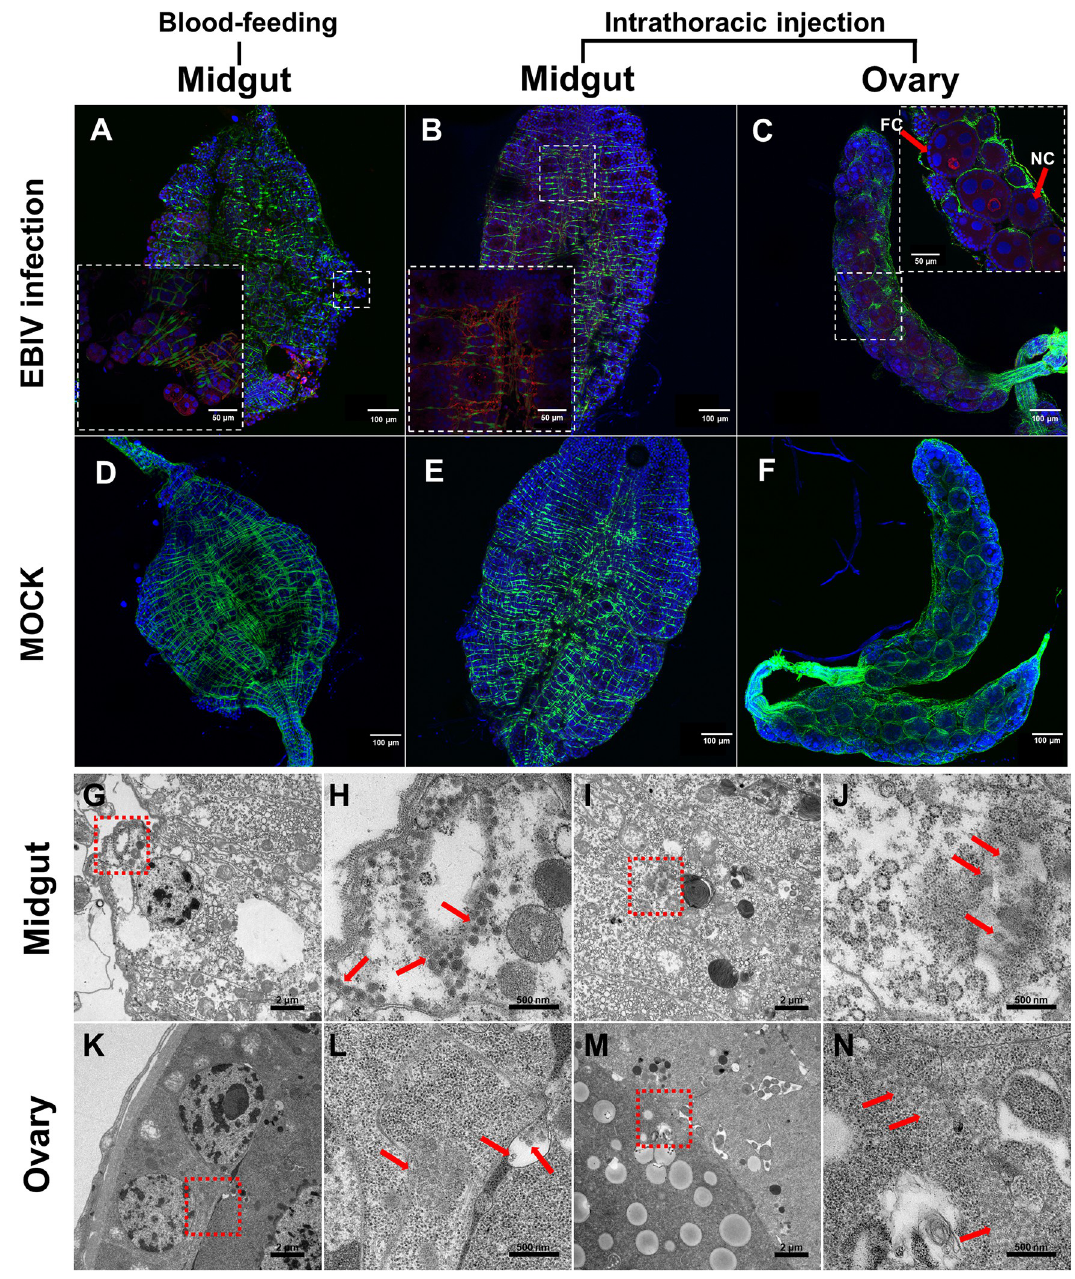
Fig 3. Immunohistochemical visualization and electron micrographs of EBIV in Ae . aegypti midgut and ovary. Immunolocalization of EBIV antigen in midguts of mosquitoes with oral infection at 14 dpi (A) and intrathoracic inoculation at 7 dpi (B). Immunolocalization of EBIV antigen in ovaries of mosquitoes infected via intrathoracic inoculation at 7 dpi (C). Immunolocalization of EBIV antigen in midguts of mosquitoes fed blood without EBIV at 14 dpi (D) and mosquitoes injected with 100 nl RPMI 1640 at 7 dpi (E). Immunolocalization of EBIV antigen in ovaries from mock-injected mosquitoes at 7 dpi (F). F-actin was stained with phalloidin (green). The cell nucleus was stained with DAPI (blue). NC: nurse cells, FC: follicle cells. (G-J) Virions observed in gut are indicated by red arrows on electron micrographs. H and J are the enlarged insets of the boxes in G and I, respectively. (K-N) Virions observed in ovary are indicated by red arrows on electron micrographs. L and N are the enlarged insets of the boxes in K and M, respectively. EBIV virion clusters were detected using a mouse anti-EBIV polyclonal antibody and goat anti- mouse IgG labeled with red fluorescent secondary antibody.